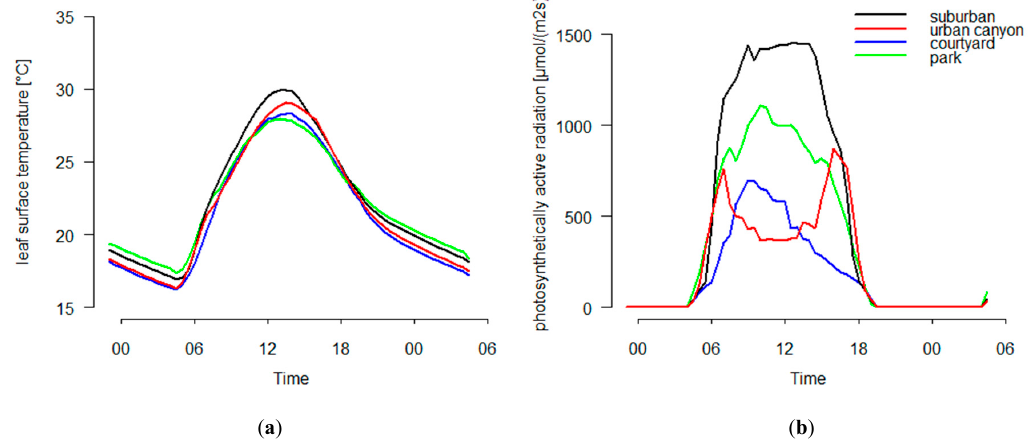
Figure 9. Diurnal simulated profile of ( a ) leaf surface temperature and ( b ) PAR for four